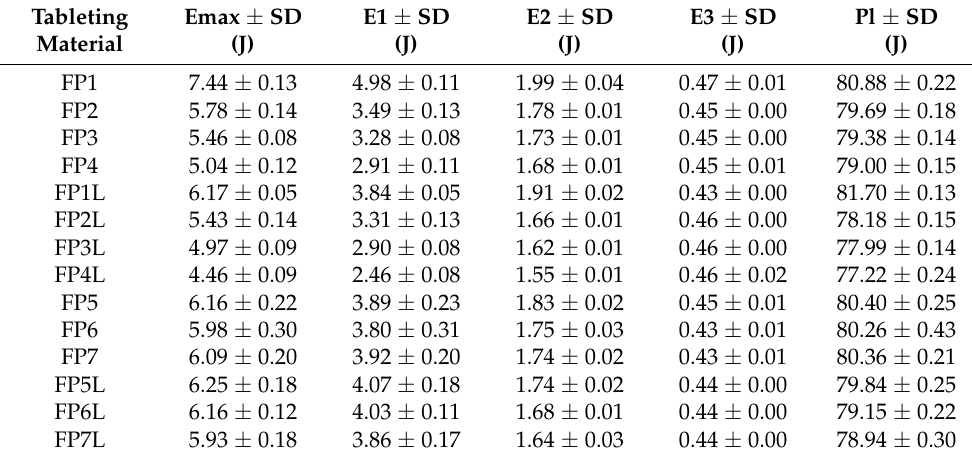
Table 4. Values of energy profile of compression and plasticity—tableting materials with chitosan and P90